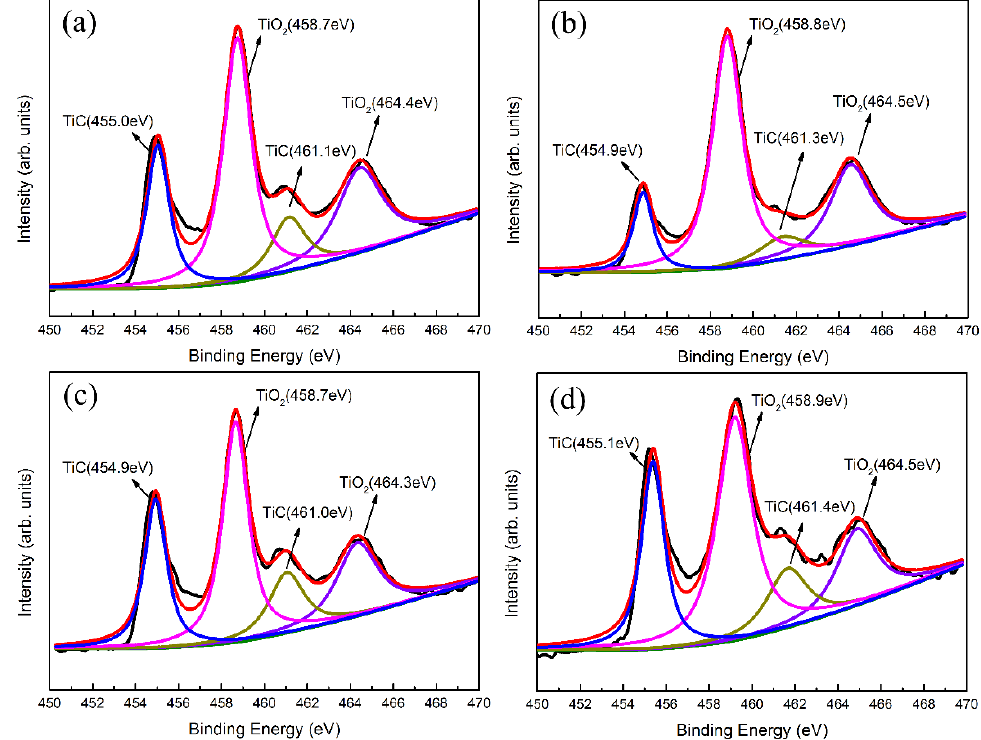
Figure 8. Ti2p XPS spectra fitting results of Ti-DLC coatings with Ti transition layer thickness ( t 0 ): ( a ) 0 μm, ( b ) 0.5 μm, ( c ) 1.1 μm and ( d ) 2.8 μm.